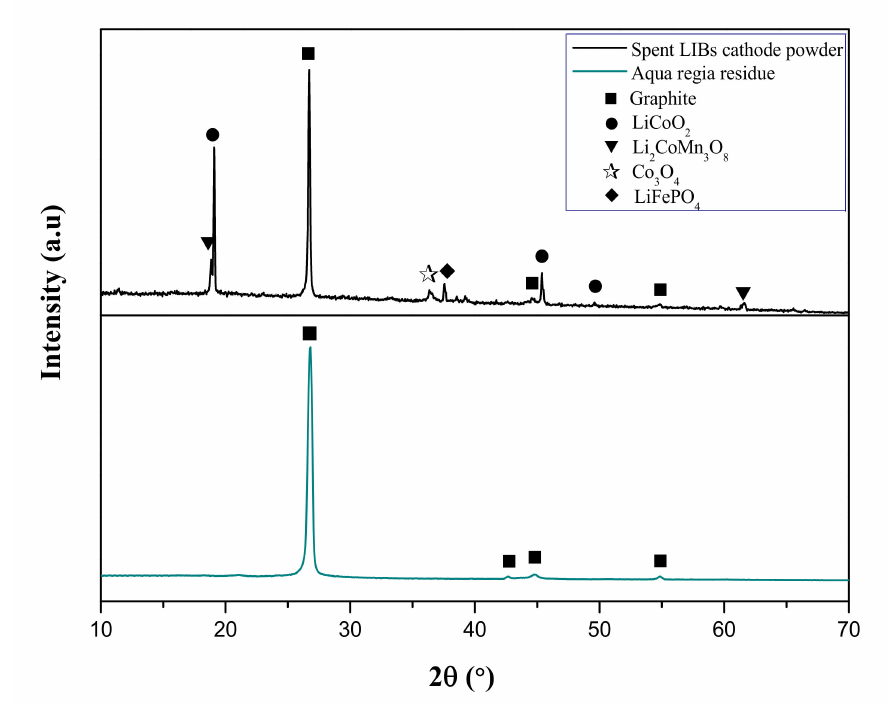
Figure 5. XRD spectra of spent LIBs’ cathode powder and residue of aqua regia digestion. Table 3. Metal compositions of cathode powder from spent